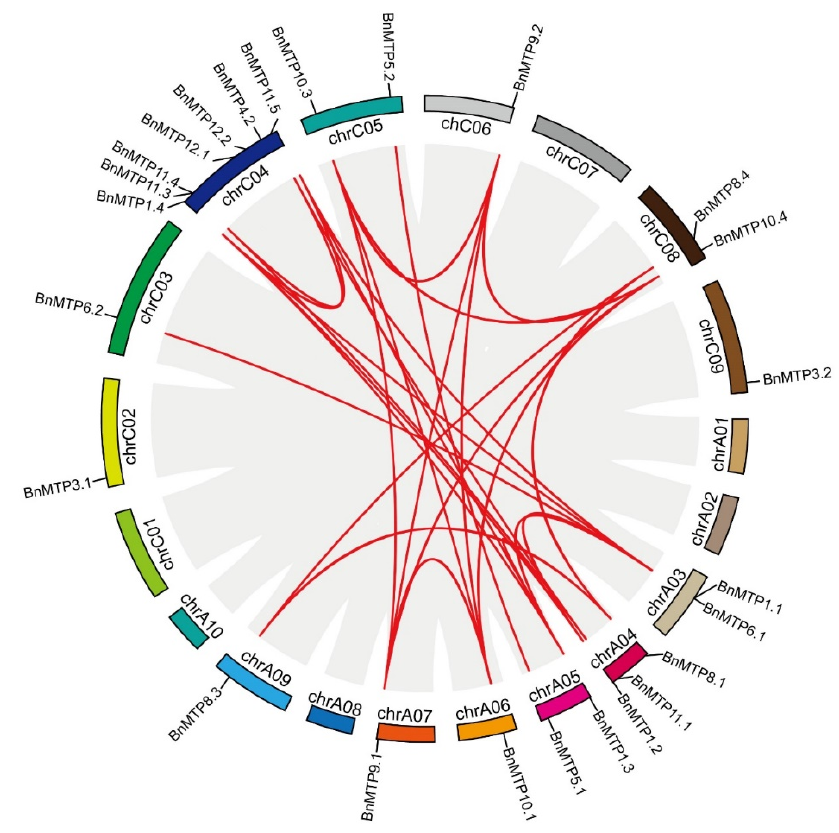
Figure 5. Chromosomal distribution and syntenic relationships of MTP genes in B. napus genome. Gray lines indicate all synteny blocks in the B. napus genome, and the red lines indicate duplicated BnMTP gene pairs.